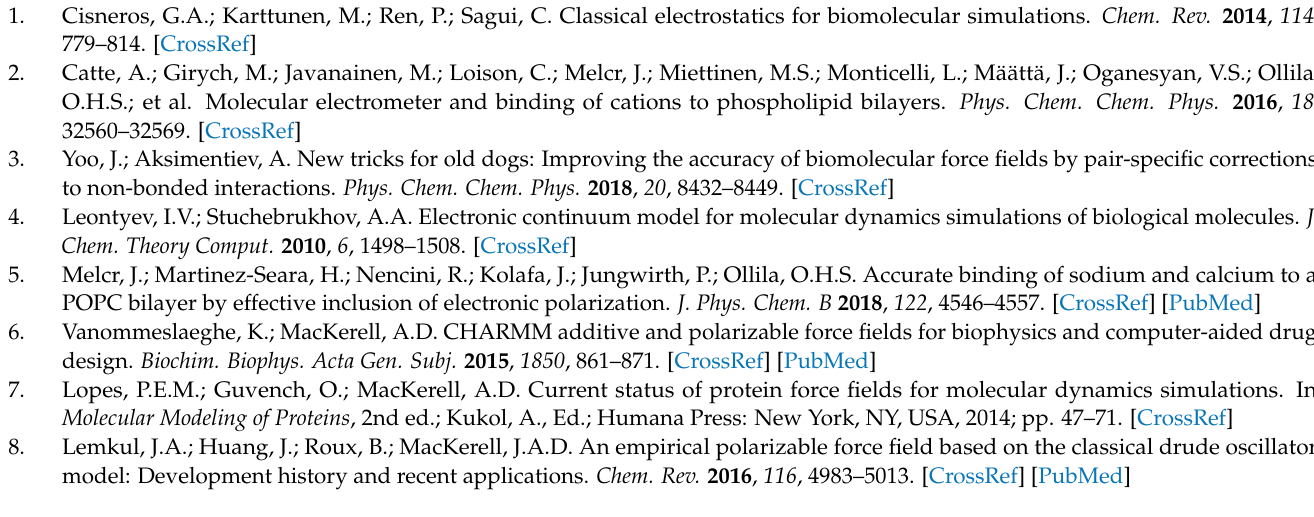
mations; Figure S1: PASA Ramachandran plots. Red dots—experimental data; Figure S2: PGA Ramachandran plots. Red dots—experimental data; Figure S3: The integration areas of Ramachan- dran maps obtained for PASA by using AMBER force fields; Figure S4: Number of the cases of the molecular fragments of different lengths with the same conformations of monomers observed along the PASA simulation trajectory; Figure S5: Number of the cases of the molecular fragments of different lengths with the same conformations of monomers observed along the PGA simulation trajectory; Figure S6: Fractions of different conformations for different force fields; Figure S7: Au- tocorrelation functions of the time dependence of the end-end distance for all considered systems; Figure S8: Autocorrelation functions of the Ψ and Φ dihedral angles for all considered